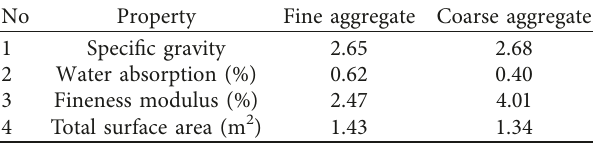
Table 2: Properties of fine and coarse aggregates.